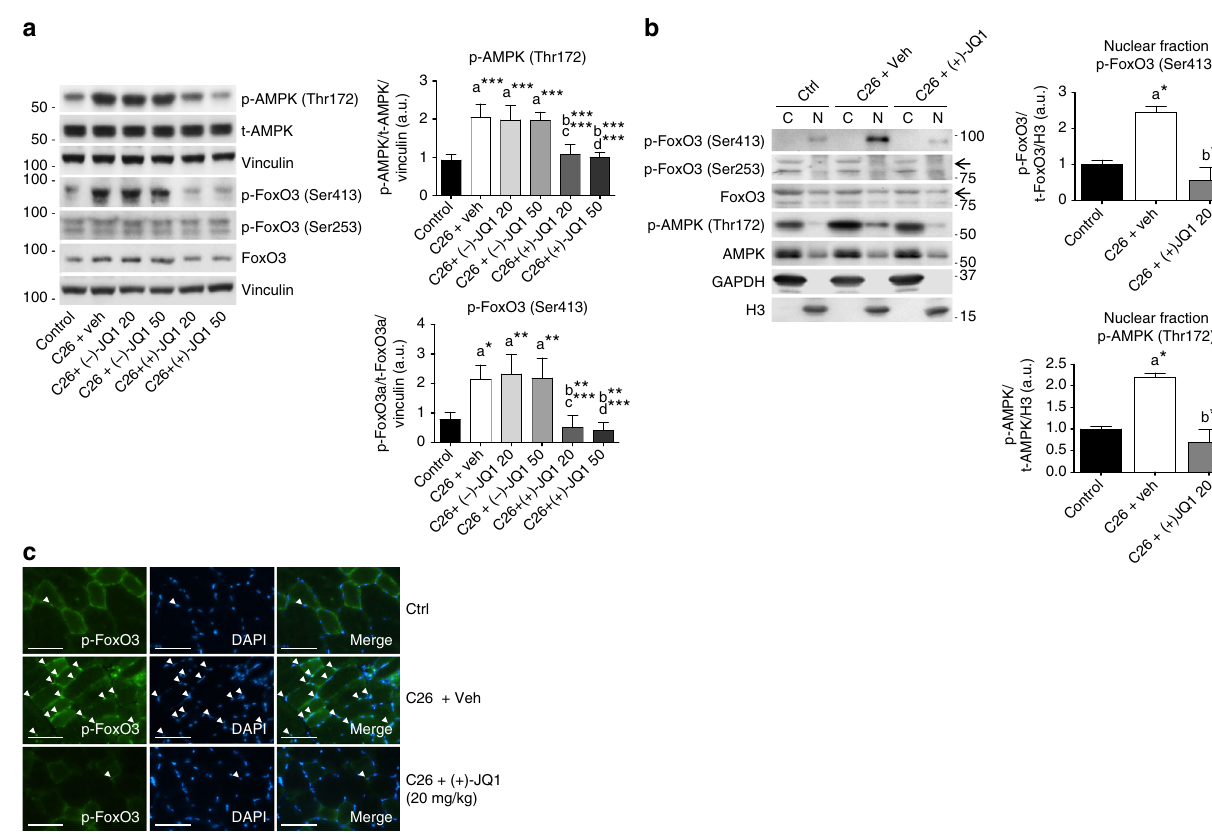
Fig. 6 p-FoxO3Ser413 and p-AMPKThr172 levels increase in muscles from cachectic mice. a Left panel: representative western blot of p-AMPK (Thr172) and total AMPK, p-FoxO3 (Ser413), p-FoxO3 (Ser253), total FoxO3 levels in TA extracts from control animals and tumor-bearing mice treated with vehicle, ( − )-JQ1, and (+)-JQ1. Vinculin serves as loading control. Middle panel: average normalized values of band intensity for p-AMPK (Thr172). Right panel: average normalized values of band intensity for p-FoxO3 (Ser413) (animals per group: n = 4 – 6). Data represent means ± SD. Statistical analysis was performed by using one-way ANOVA followed by Tukey ’ s post hoc test. * p < 0.05; ** p < 0.01; *** p < 0.001. “ a ” indicates statistical signi fi cance compared to control; “ b ” indicates statistical signi fi cance compared to C26 + vehicle; “ c ” indicates statistical signi fi cance compared to C26 + ( − )-JQ1 20 mg/kg/day; “ d ” indicates statistical signi fi cance compared to C26 + ( − )-JQ1 50 mg/kg/day. b Left panel: representative western blot analysis of p-FoxO3 (Ser413), p-FoxO3 (Ser253), total FoxO3, p-AMPK (Thr172) and total AMPK in nuclear/cytoplasmic extracts of TAs from control and tumor-bearing mice treated with vehicle or (+)-JQ1 (20 mg/ml/day). Three animals were used for each experimental group. Middle panel: average normalized values of band intensity for p-FoxO3 (Ser413) in nuclear fraction. Right panel: average normalized values of band intensity for p-AMPK (Thr172) in nuclear extracts. Statistical analysis was performed by using one-way ANOVA followed by Tukey ’ s post hoc test. * p < 0.05; ** p < 0.01. “ a ” indicates statistical signi fi cance compared to control; “ b ” indicates statistical signi fi cance compared to C26 + vehicle. c Frozen TA sections (animals per group: n = 3) were stained with